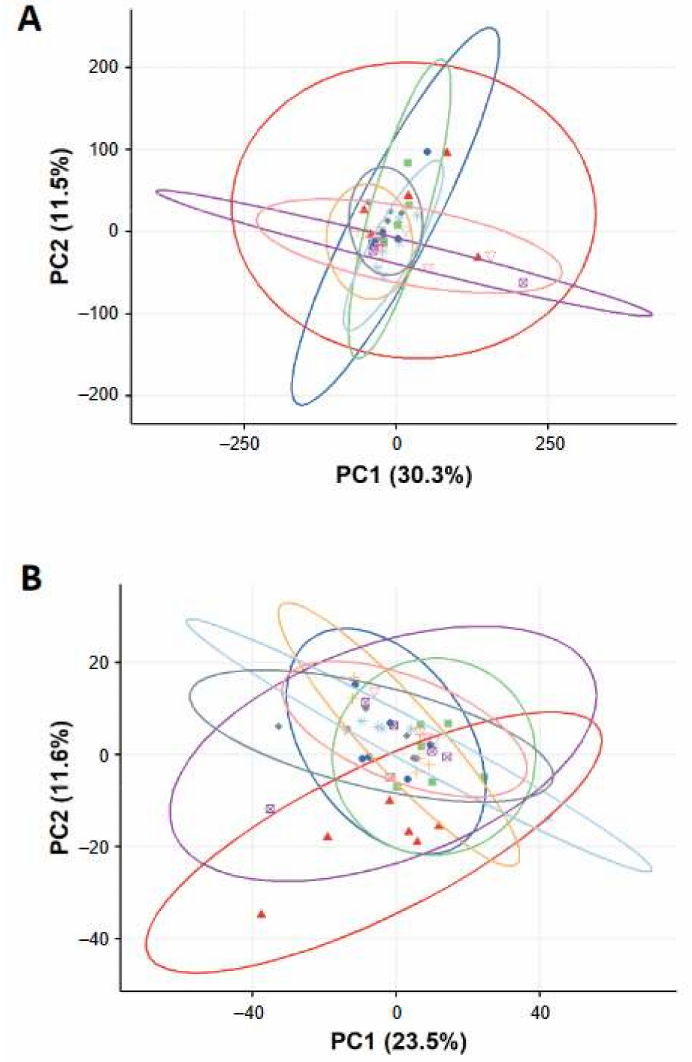
Figure 6. Principal component analysis (PCA) score plots of the gene expression ( A ) and metabolomics profiles ( B ) of lung tissue from rats exposed to control and FeO x NP aerosols. Symbols in the PCA plots indicate individual samples of rat lungs exposed to Water at one day (circle ) or 7 days (triangle ) post-exposure, Fe 3 O 4 (low dose) at one day (square ) or seven days (plus ) post-exposure, Fe 3 O 4 (high dose) at one day (square with cross ) or seven days (astrix ) post-exposure, and FeO x -mix (high dose) at one day (diamond ) and seven days (inverted triangle ) post-exposure.